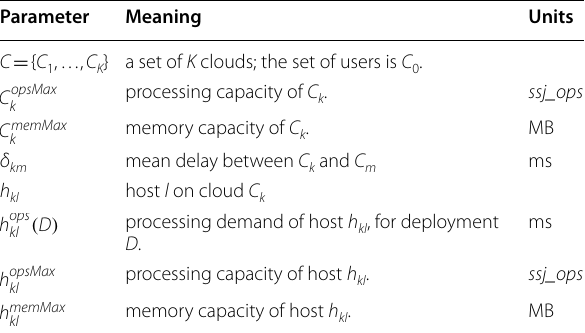
Table 2 Cloud and Host Property